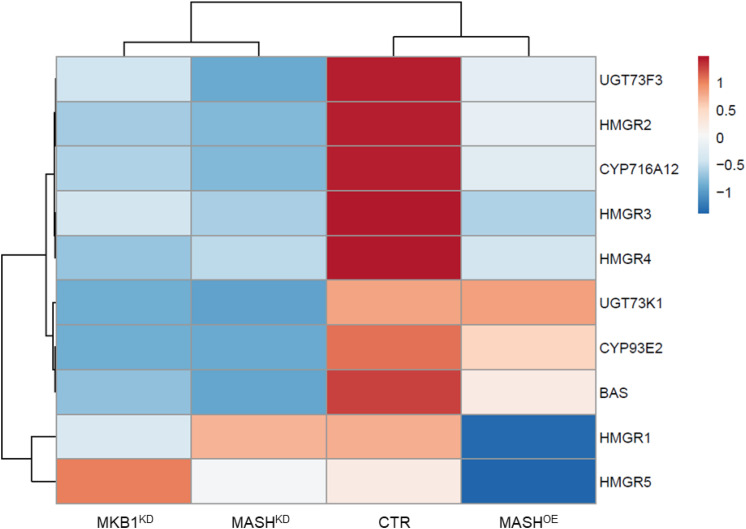
Quantitative reverse transcription PCR (RT-qPCR) analysis of TS genes in control (CTR), MKB1KD, MASHKD, and MASHOE Roots. Heat map generated through ClustVis showing differentially expressed TS biosynthesis genes in CTR, MKB1KD, MASHKD, and MASHOE roots. Rows are centered; unit variance scaling is applied to rows. Both rows and columns are clustered using correlation distance and average linkage. Exact expression values are given in Supplementary Table 3.